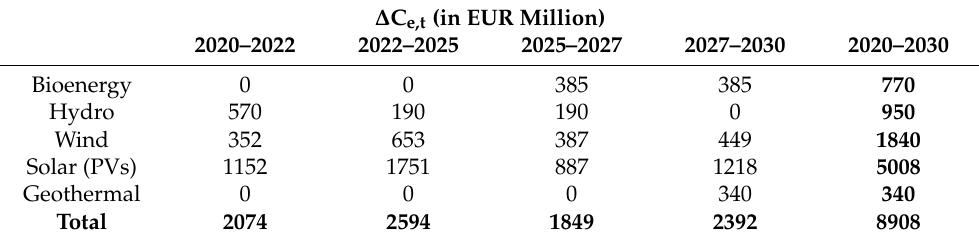
Table 5. Estimates of new investment cost per RES type and time period.